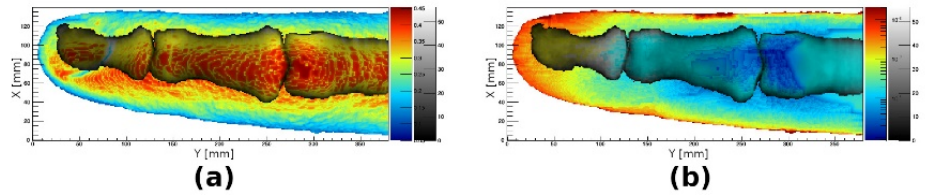
Figure 8. Reflectance ( a ) and transmittance ( b ) images resulting from optical simulation using the index finger model. Images are overlaid in grayscale showing the total thickness of the bone tissue in the model.